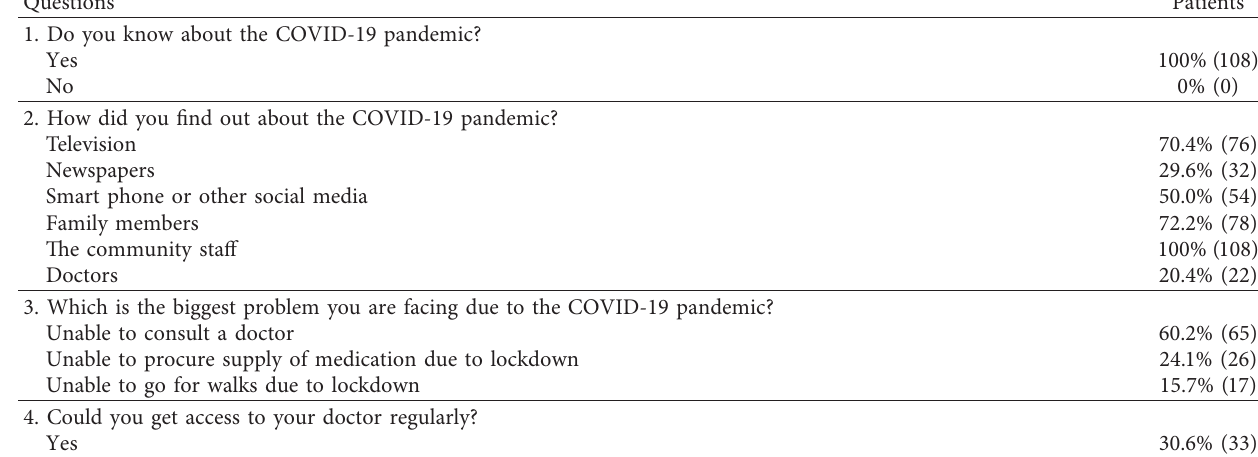
Table 1: COVID-19 Questionnaire for PD Patients during the Period of Epidemic Prevention and Control.